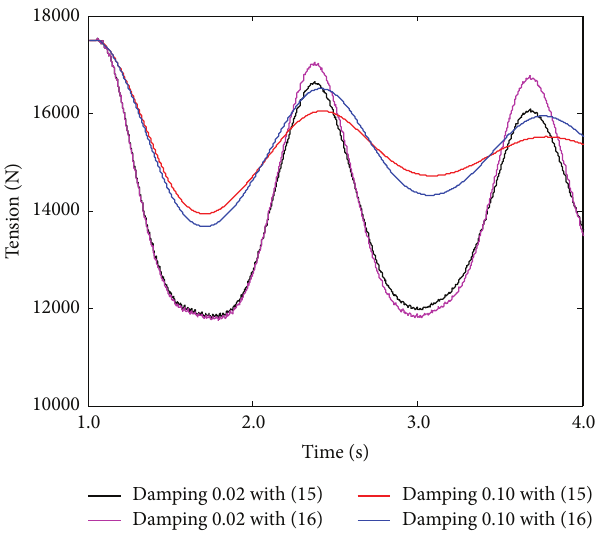
Figure 7: Comparison of midpoint displacements obtained with different damping